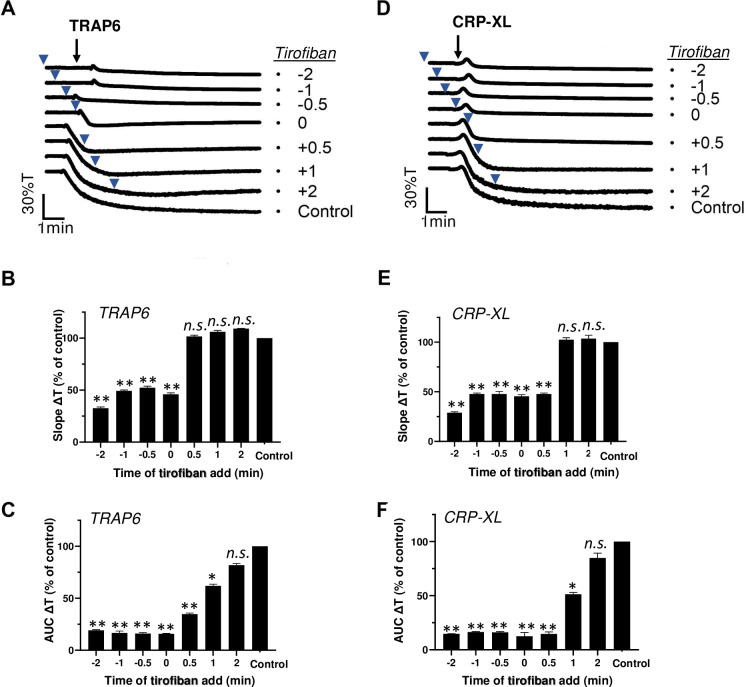
Post-hoc inhibitory effect of integrin antagonist on TRAP6- and CRP-XL-induced platelet aggregation.Platelets in suspension were stimulated with 10 μM TRAP6 (A-C) or 5 μg/mL CRP-XL (D-F), and aggregation was recorded by light transmission aggregometry. Tirofiban (1 μg/mL) was added before (-2, -1 or -0.5 min), simultaneously with (0 min) or after (+0.5, +1, +2 min) the indicated agonist. Representative traces are shown; arrows indicate addition of agonist, arrowheads addition of tirofiban (A, D). Bar graphs indicate the aggregation slope as %T/min (B, E) and aggregation-area-under-the-curve (AUC, 10 min) (C, F), as fractions of control without tirofiban. Means ± SEM (n = 3). *P<0.05, **P<0.001 vs. control traces, paired Student t-test.